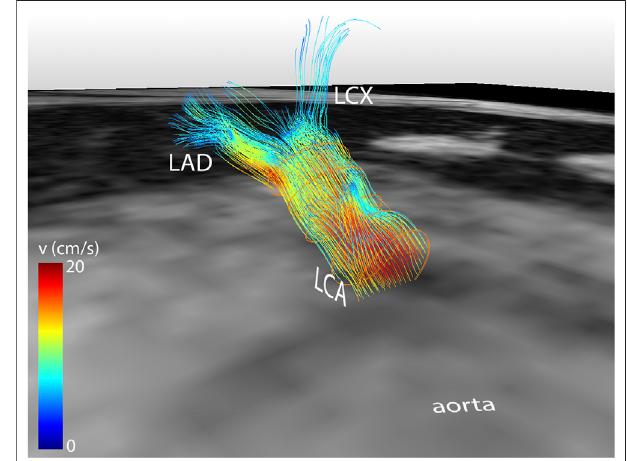
FIGURE 4 | Streamline reconstruction of 4D fl ow MRI-derived velocities intheLCAforamid-diastolictimeframe.Streamlinesinitiatefrom fi vecontours placed in the LCA and split into LAD and LCX. Velocity color-coding shows that the measured velocities in the LAD and LCX are lower than in the